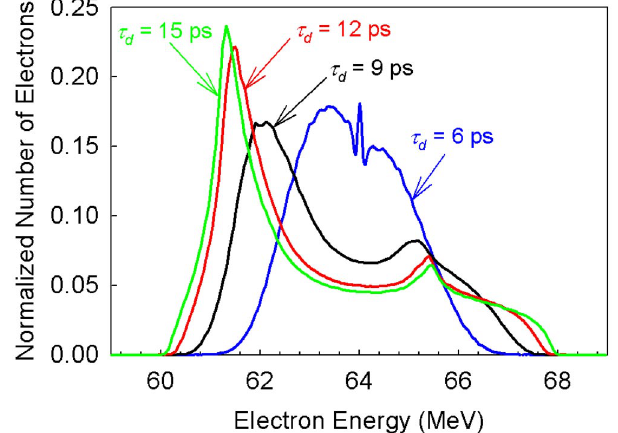
FIG. 4. (Color) Model prediction for energy spectrum of witness (cid:1) 2 : 97 ps and different time delays between the bunch for t d seed and witness e -beam bunches for an acceleration length (cid:1) 2 mm . L acc